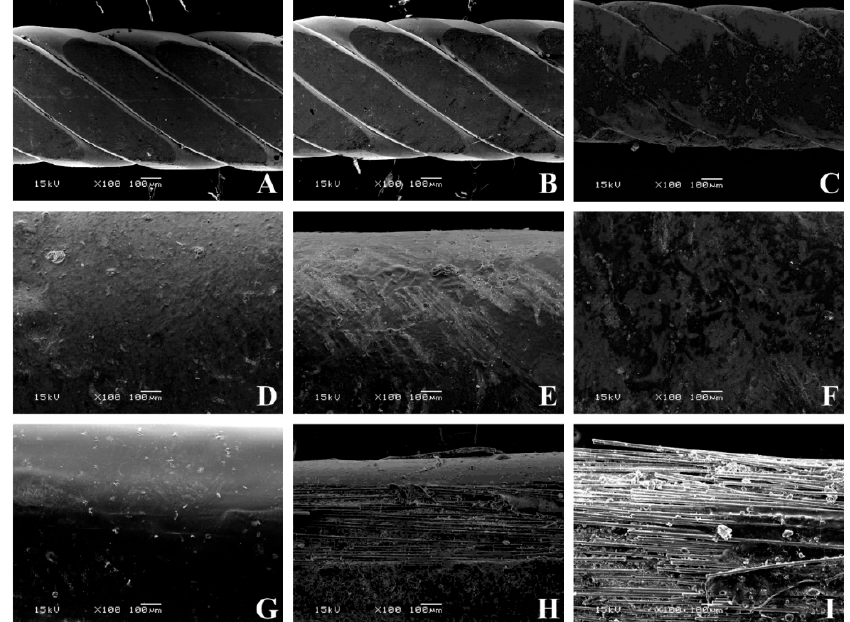
Figure 6. SEM pictures of various conditions tested at 100 × magnification. ( A ) Flat metallic wire not brushed, ( B ) flat metallic wire brushed for 26 min, ( C ) flat metallic wire brushed for 60 min, ( D ) full-bonded FRC not brushed, ( E ) full-bonded FRC brushed for 26 min ( F ) full-bonded FRC brushed for 60 min, ( G ) spot-bonded FRC not brushed, ( H ) full-bonded FRC brushed for 26 min, ( I ) full-bonded FRC brushed for 60 min.